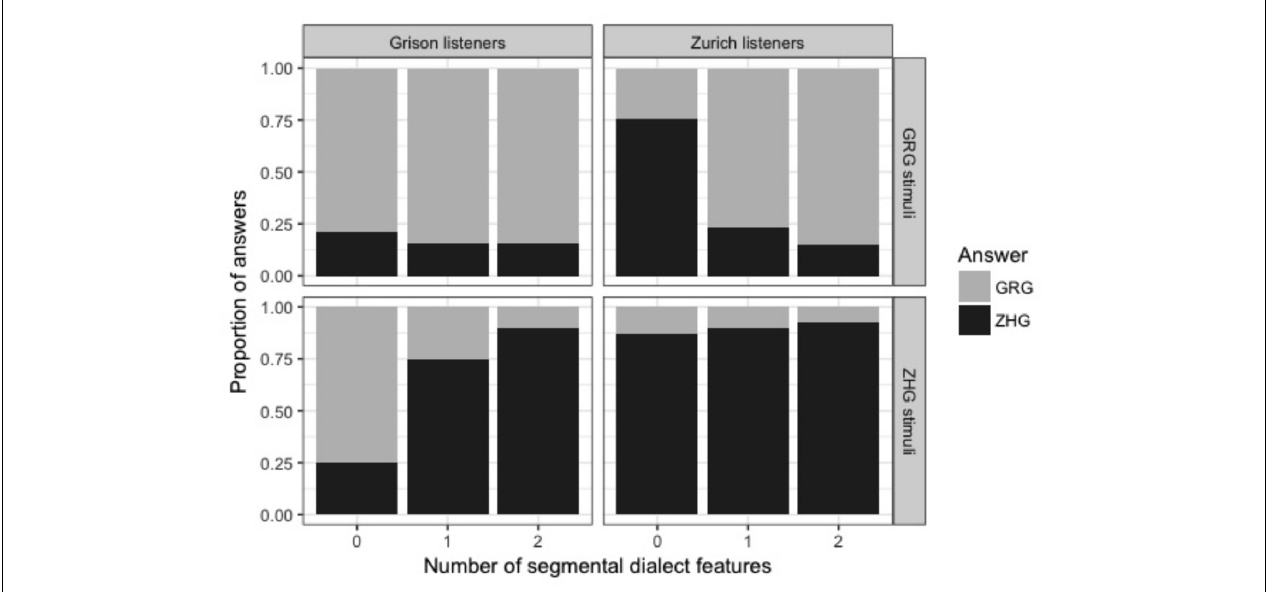
FIGURE 1 | Distribution of dialect answers (black: ZHG; grey: GRG) according to a listener’s origin (columns; Grison and Zurich listeners) and the speaker’s dialect (rows; GRG and ZHG stimuli).